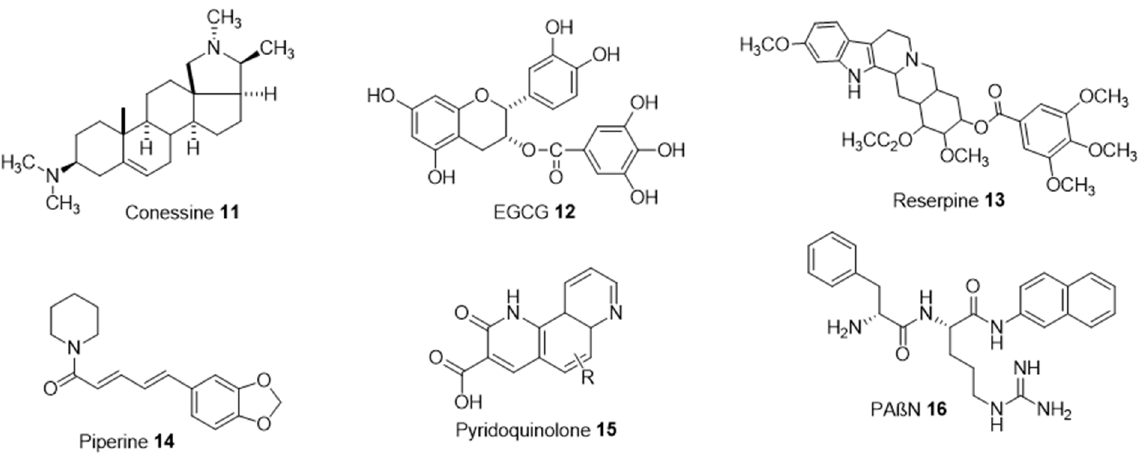
Figure 4 . Structure of efflux pumps inhibitors 11 - 16